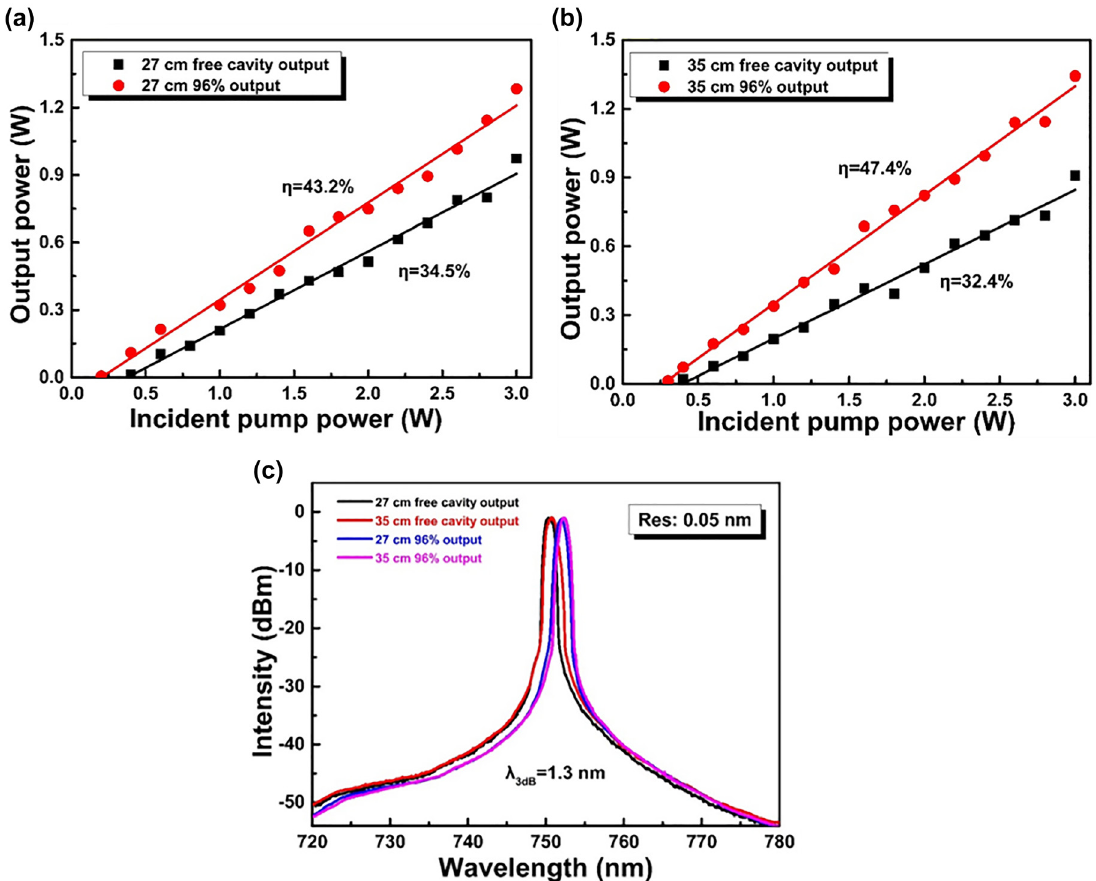
Figure 6: Deep-red laser output characteristics at different active fiber lengths (27 cm, 35 cm) and different output